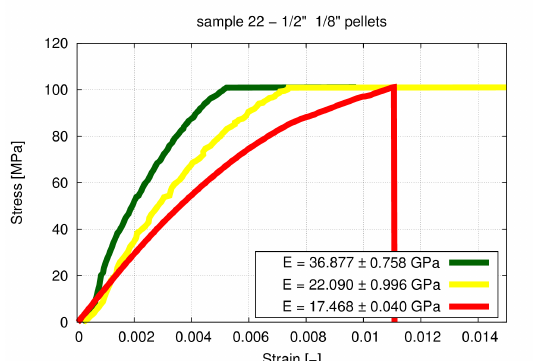
Figure 8. Stress-strain diagram of 13 × 3 . 25 mm pellets; Sample 22.